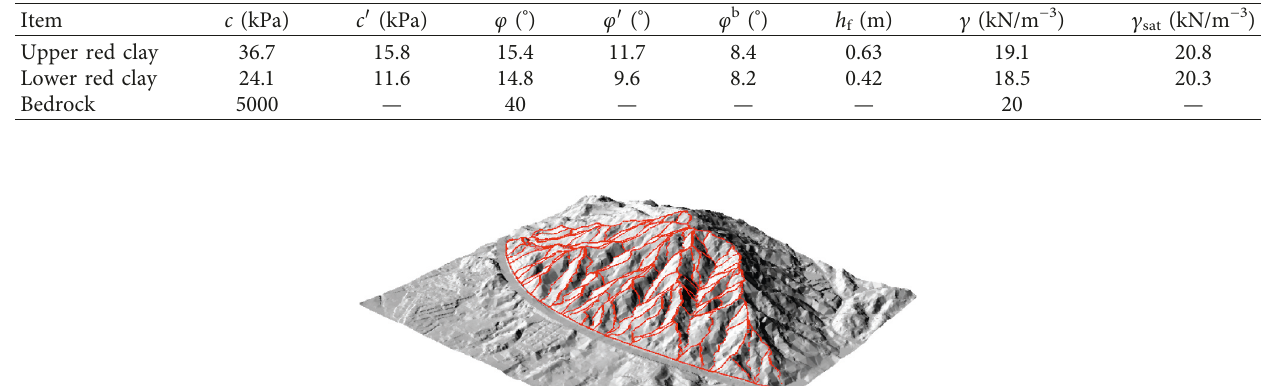
Figure 9: Hillshade of the study area (unit: m). Table 4: Physical and mechanical indexes of red clay and bedrock.